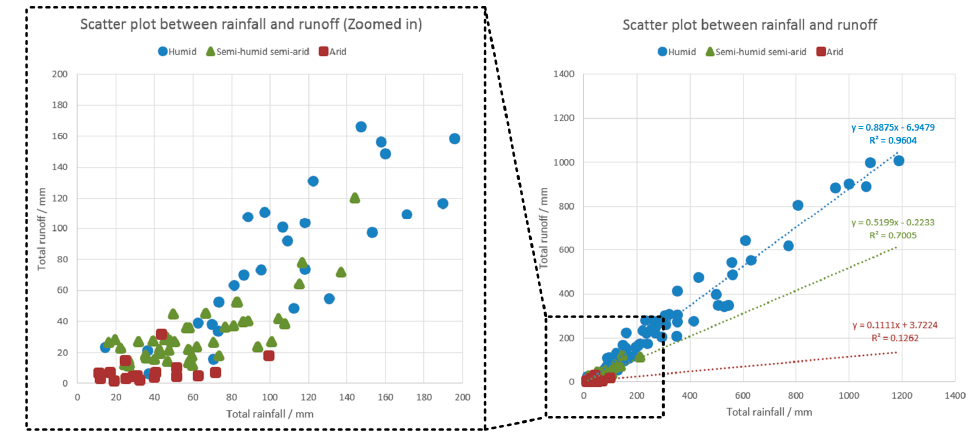
Figure 2. Scatter plot between rainfall and runoff.